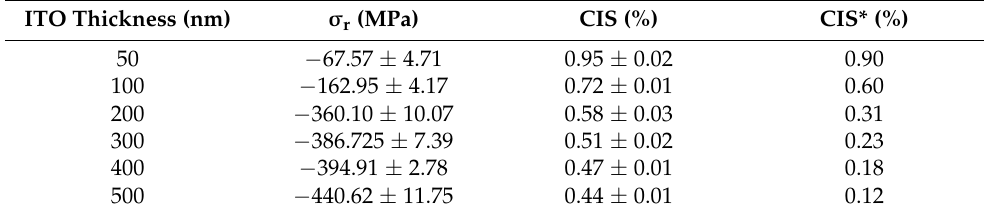
Figure 8. Film thickness dependence of internal stress measured crack initiation strain, and intrinsic crack initiation strain of ITO films. The thick continuous lines are power-law fits (with exponent equal to − 0.76) to CIS*. Table 1. σ r and CIS and CIS* of ITO films with different thicknesses.